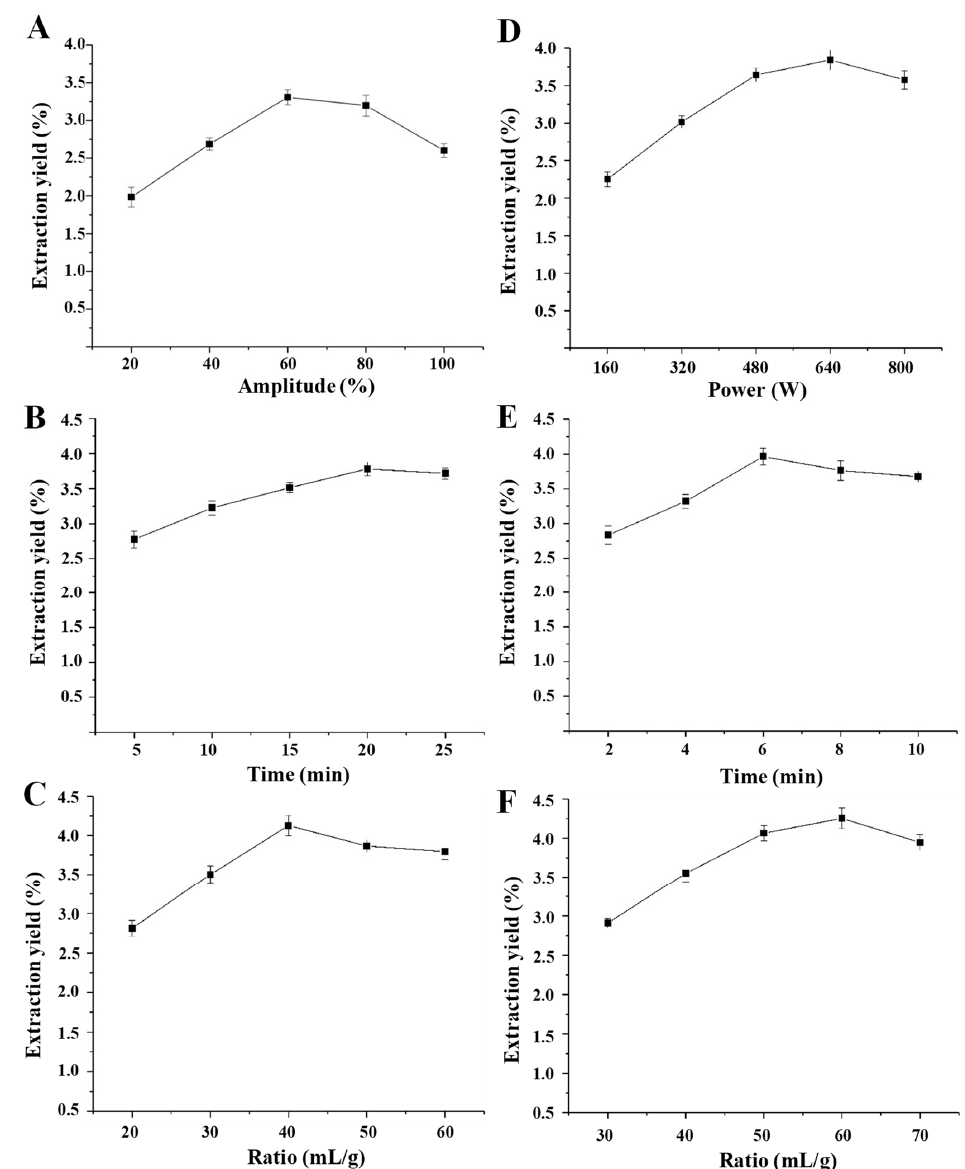
Figure 1. The effects of different extraction parameters of ultrasonic-assisted extraction and microwave-assisted extraction on the yields of polysaccharides extracted from snow chrysanthemum: ( A ) the ultrasound amplitude, ( B ) the ultrasound extraction time, and ( C ) the ratio of water to raw material of ultrasonic-assisted extraction; ( D ) the microwave power, ( E ) the microwave extraction time, and ( F ) the ratio of water to raw material of microwave-assisted extraction.